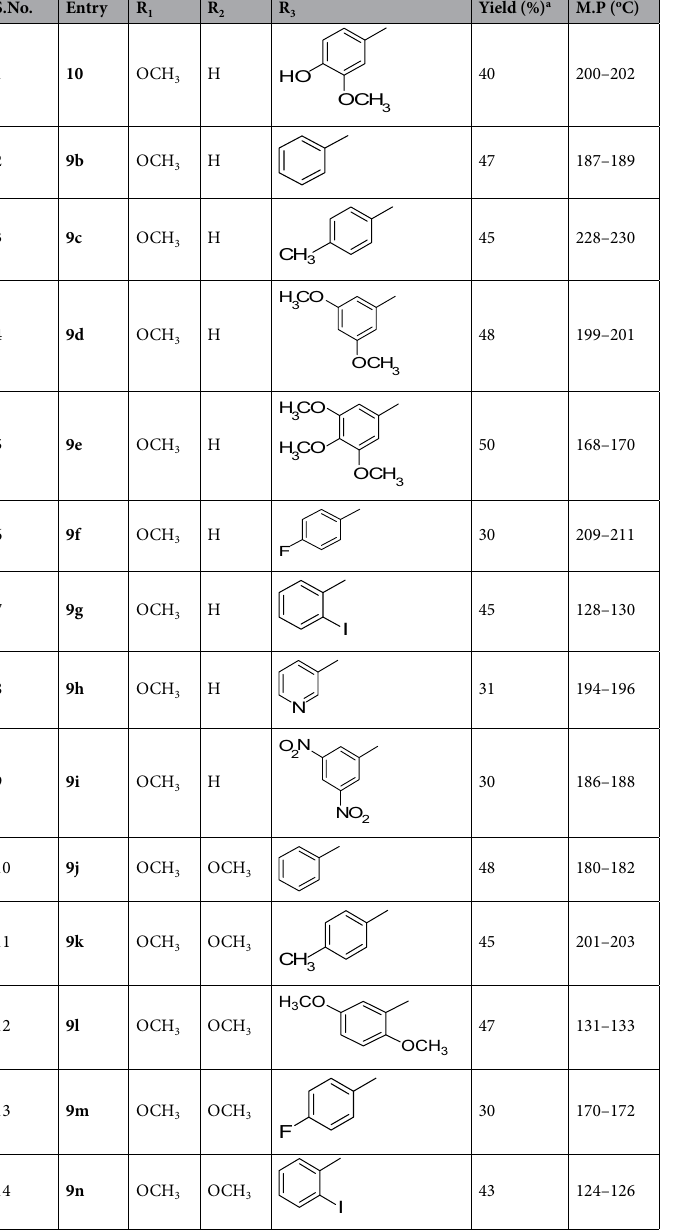
cytometry using Annexin V-PI staining. The results demonstrated that 9f caused a dose-dependent increase in the early apoptotic to late apoptotic population in MCF-7 cells (Panel C of Fig. 5; Supplementary Figure 31). Mitochondrial membrane potential loss ( Δψ m), an indicator of mitochondria membrane disruption, is a distinctive feature of the initial stages of apoptosis. In rhodamine-123 based mitochondrial membrane potential ( Δψ m) assay, 9f caused 41.33 ± 1.43% and 52.67 ± 2.33% mitochondria membrane potential loss in MCF-7 cells at 5 and 10 µ M concentrations, respectively. Similarly, camptothecin (positive control) caused 53.33 ± 3.06% and 62 ± 2.31% mitochondrion membrane potential loss in MCF-7 cells at 5 and 10 µ M concentrations, respectively, (Fig. 5 panel D). Bcl-2 and Bax expression levels are associated with integrity of mitochondria membrane and involved in the regulation of apoptosis. Compound 9f showed dose dependent inhibition of Bcl-2 in treated MCF-7 breast cancer cells as compared to untreated cells (Fig. 5, panel E). Bax protein levels are dose dependently increased in treated MCF-7 cancer cells compared to untreated cells (Fig. 5, panel F). Overall, these results demonstrate the decreasing the ratio of Bcl-2/Bax in 9f -treated MCF-7 cancer cells (Fig. 5). This is one of the indi- cations of apoptosis. Cytosolic cytochrome c levels elevation is a hallmark of apoptosis. To determine the release of cytochrome c from mitochondria into cytosol, cytosolic fractions were collected from the MCF-7 cells treated with compound 9f (5, 10 µ M), and subjected to antibody coated ELISA based protein level estimation. Cytosolic